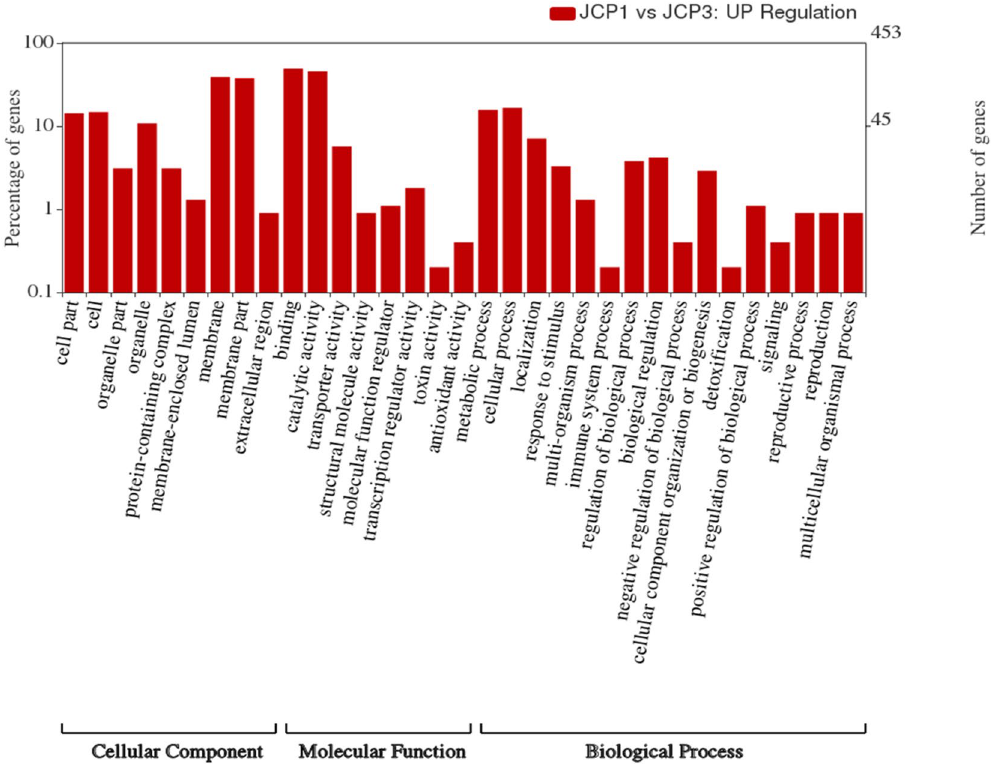
Figure 5. Gene ontology classification analysis of the up-regulated DEGs. GO functions were represented in X-axis; the number of DEGs annotated in each GO term was presented in left Y-axis; and the right Y-axis showed the percentage of DEGs which were annotated in each GO term.